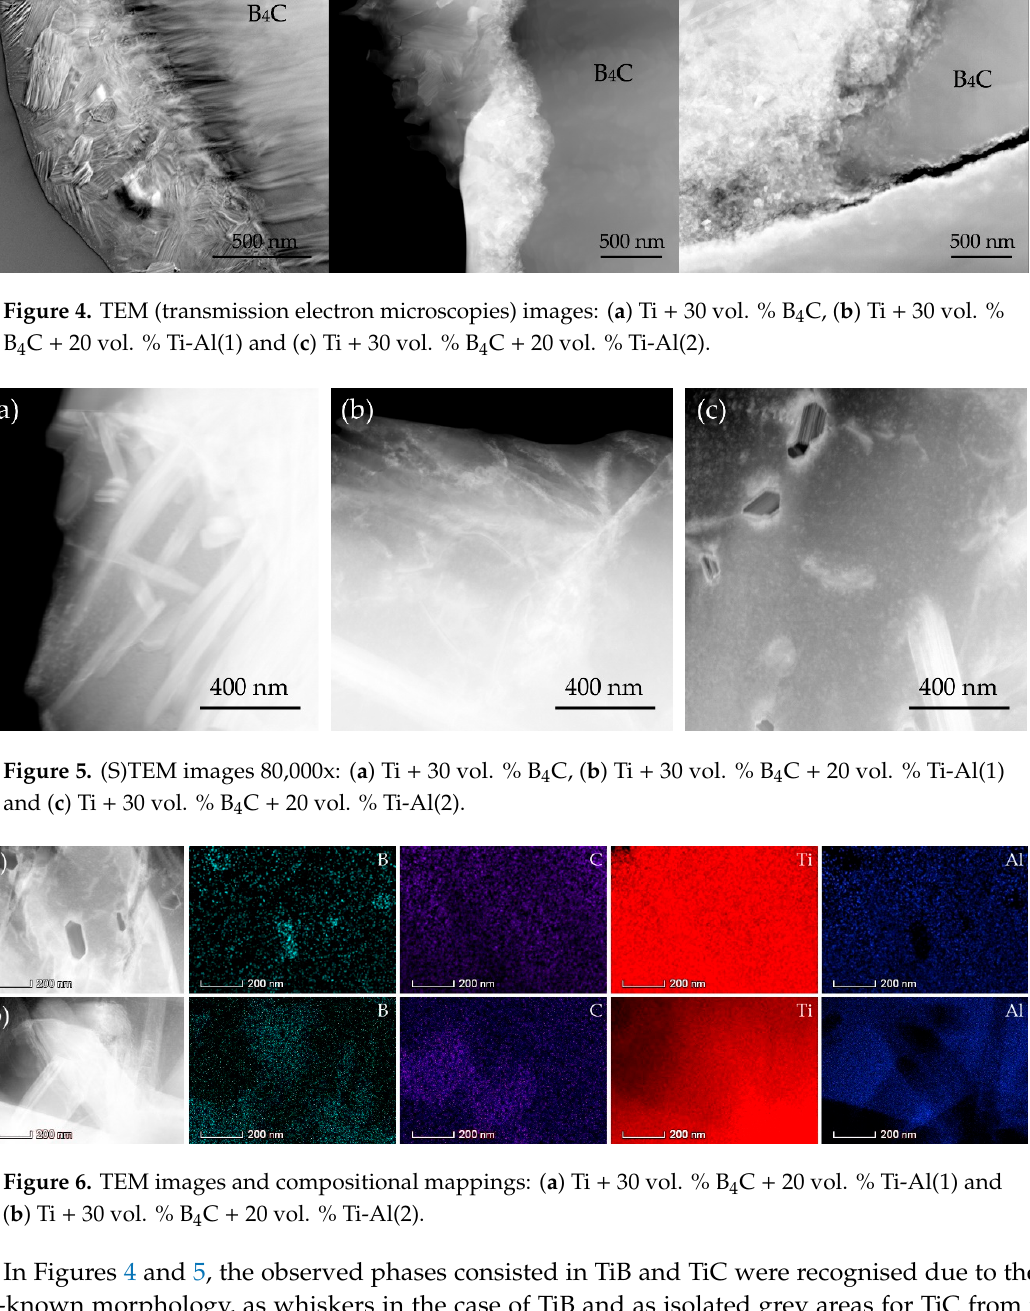
Figure 4. TEM (transmission electron microscopies) images: ( a ) Ti + 30 vol. % B 4 C, ( b ) Ti + 30 vol. % B 4 C + 20 vol. % Ti-Al(1) and ( c ) Ti + 30 vol. % B 4 C + 20 vol. % Ti-Al(2).